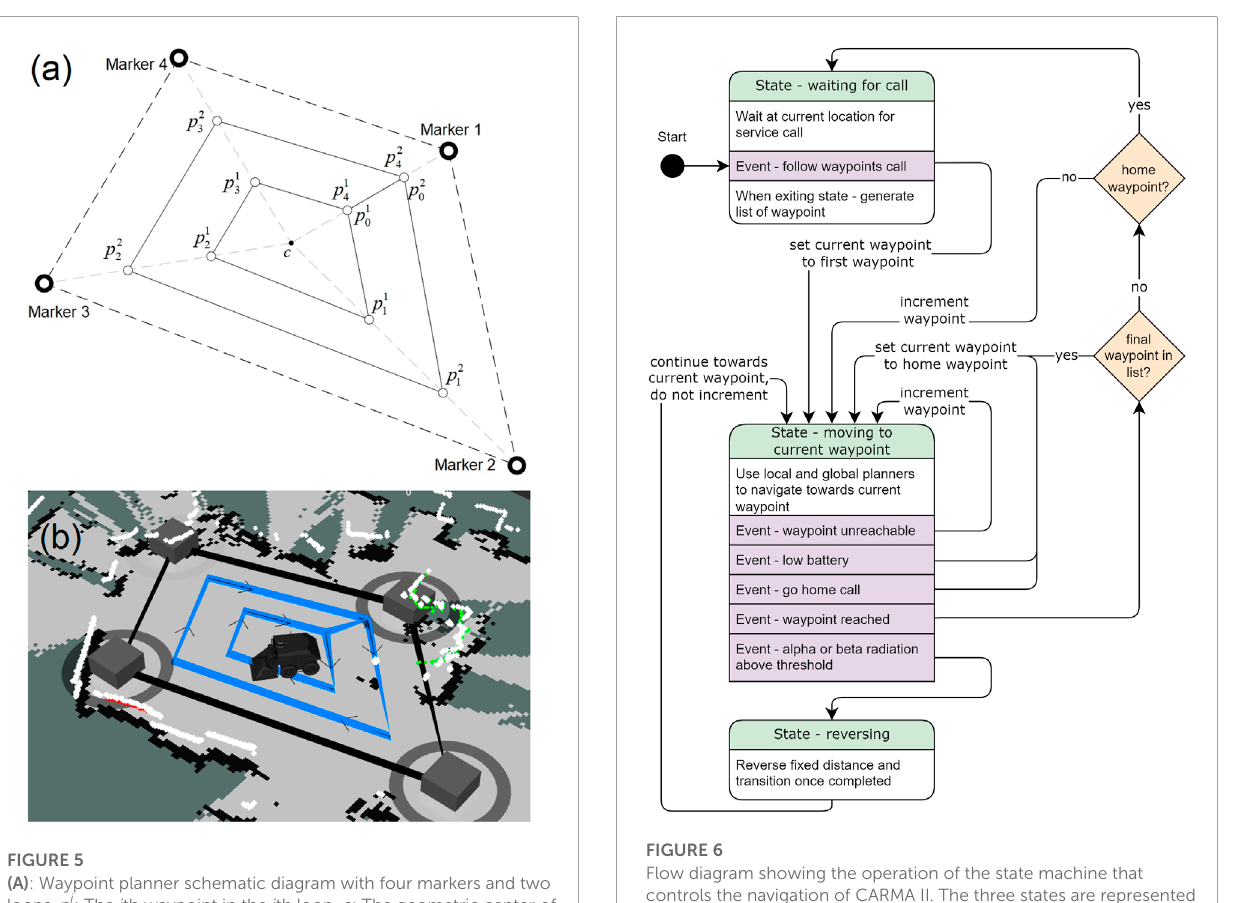
and y directions. Radial lines are then drawn from point c to each interactive marker. Considering the number of loops, the position of waypoints in each radial line distributed equally between point c and the corresponding interactive marker is obtained and the concentric loops are plotted as depicted in Figure 5A .